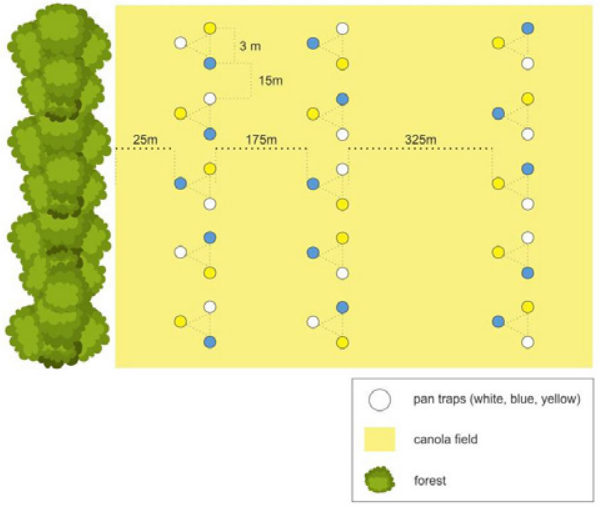
Fig 1 . Schematic representation of pan traps’arrangement within the canola fields for bee